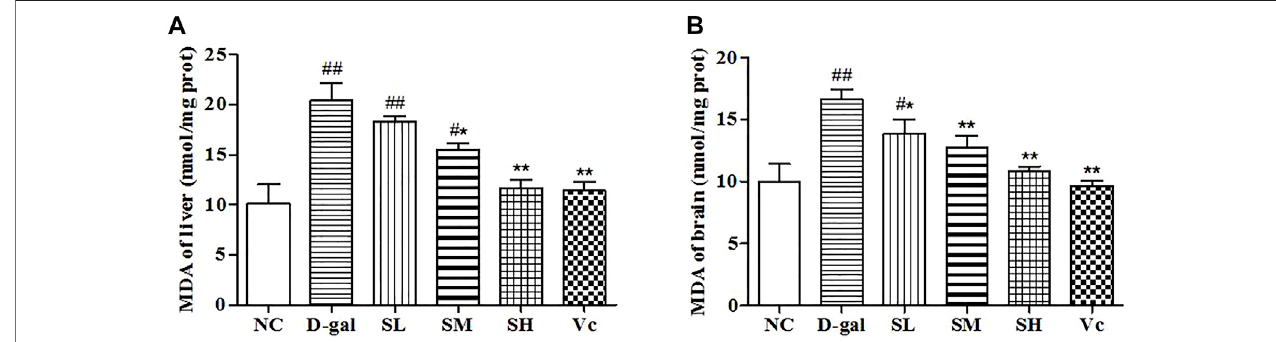
FIGURE5| TheMDAcontentofliver (A) andbrain (B) inmice.Comparedwithnormalgroup,#: p < 0.05,##: p < 0.01;ComparedwithD – galgroup,*: p < 0.05,**: p < 0.01. NC: normal control group; D – gal: D – gal model group; SL: low – dose SDE group; SM: medium – dose SDE group; SL: high – dose SDE group; Vc: Vc positive control group.